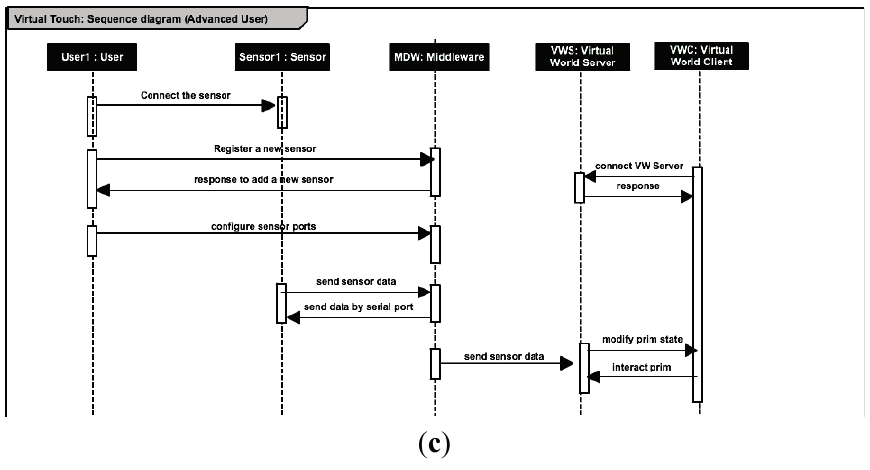
Figure 6. Sequence diagrams of the actions that the basic user ( a ); the intermediate user ( b ) and the advanced user; ( c ) can perform in order to interact with the